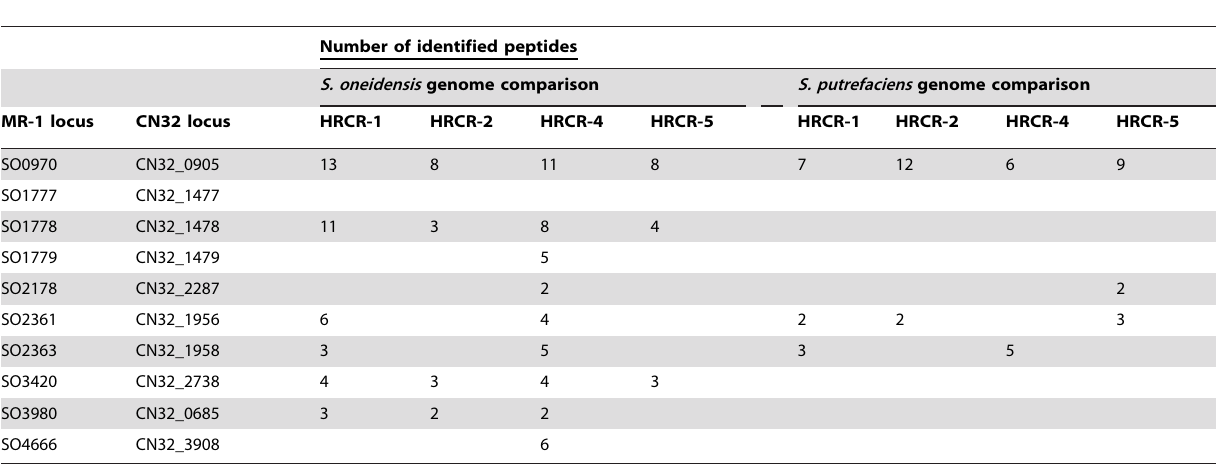
Table 2. Shewanella isolates were identified from the Columbia River, based on 16S rDNA sequencing.